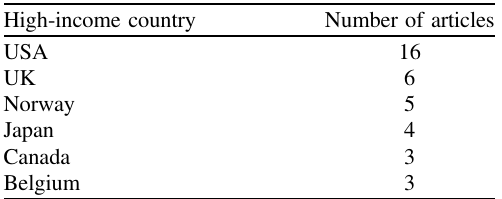
Table 4. Top high-income countries collaborating with research in low-income countries, 2007 – 2017.